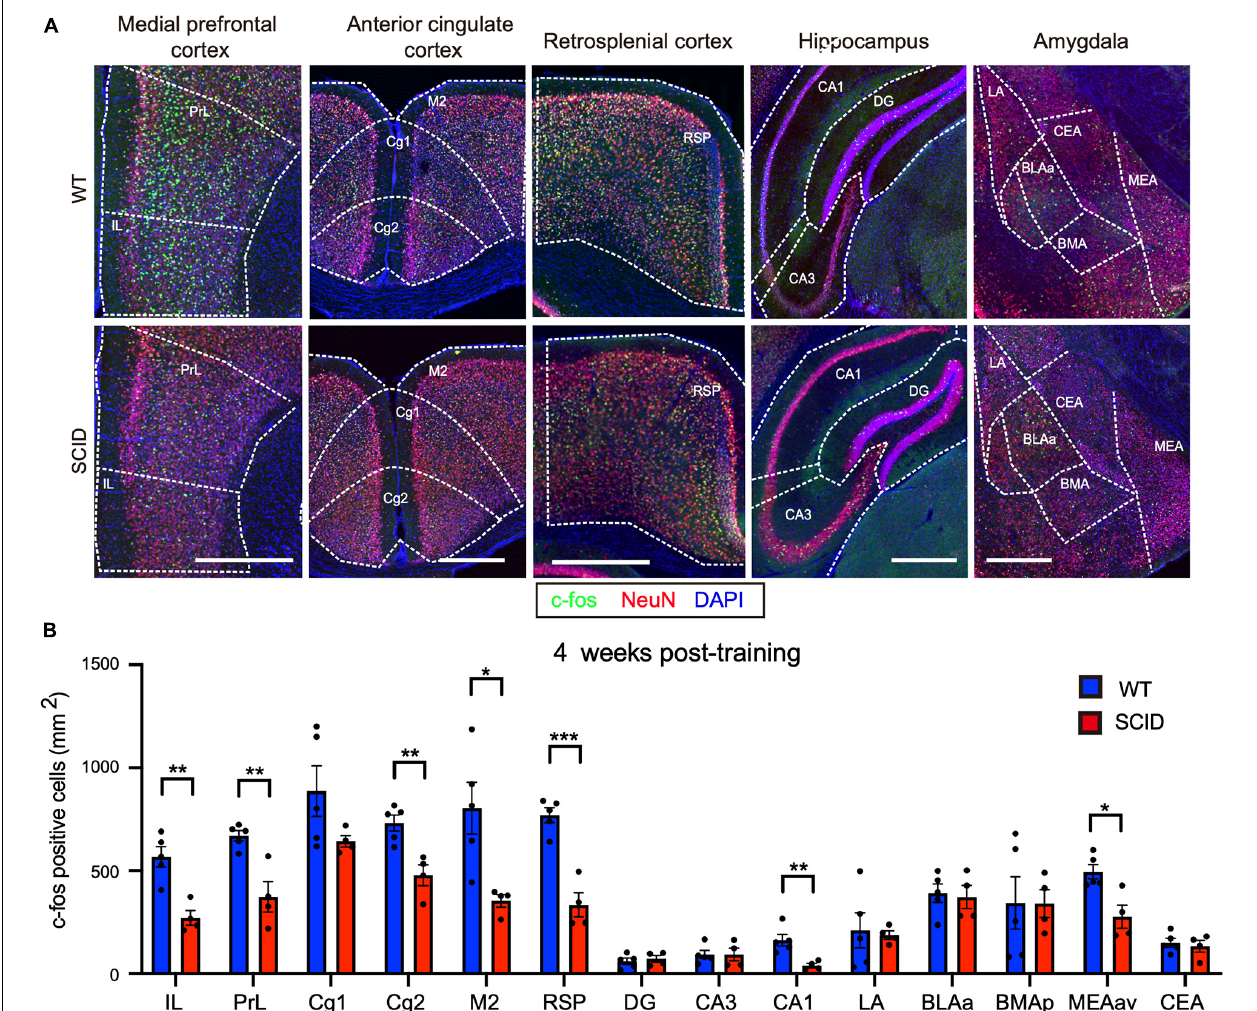
FIGURE 3 | Significantly lower neuronal activity in memory-associated brain regions of SCID mice after remote memory retrieval. (A) Representative immunofluorescence images of five different brain regions from WT and SCID mice after remote memory retrieval (4 weeks after CFC training). c-Fos is in green, NeuN in red, and DAPI in blue. Scale bar, 500 µ m. (B) c-Fos–positive cell density in the brain regions of WT and SCID mice after remote memory retrieval ( n = 4–5 per group; data represent mean ± SEM, * p < 0.05, ** p < 0.01, *** p <